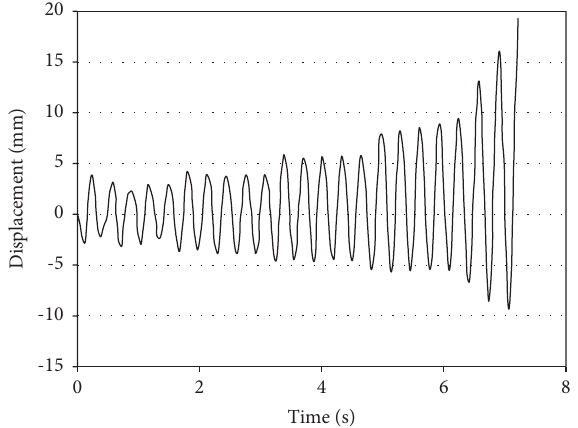
Figure 3: Inelastic displacement-time history